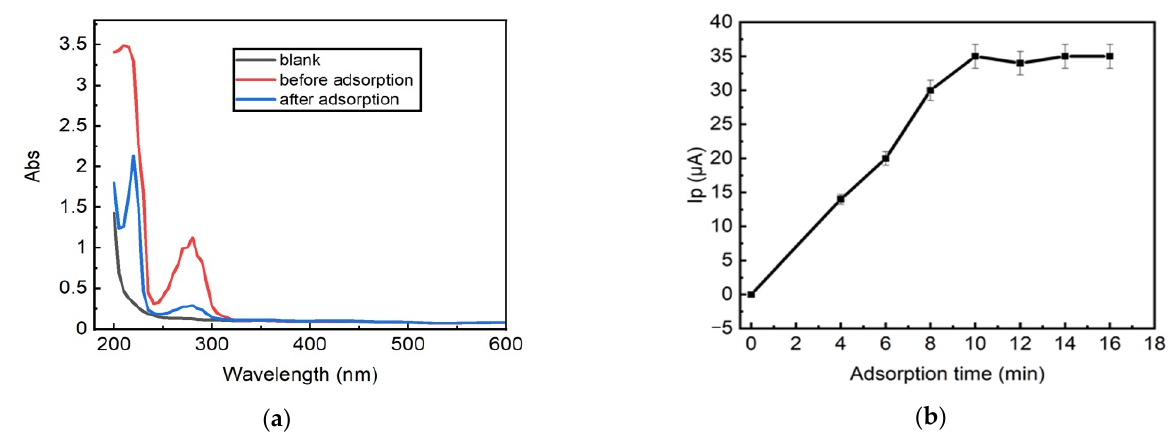
Figure 7. ( a ) UV-vis spectra of carbaryl solution (16 mg/L) in mixture of 96% ethanol and deionized water (1:1) before and after adsorptive accumulation on the LRGO grid electrode. Blank—96% ethanol and deionized water (1:1), measured in 4 µL cuvettes. ( b ) Influence of adsorptive accumulation time on the LSV anodic peak current of carbaryl (16 mg/L) on the LRGO grid electrode.